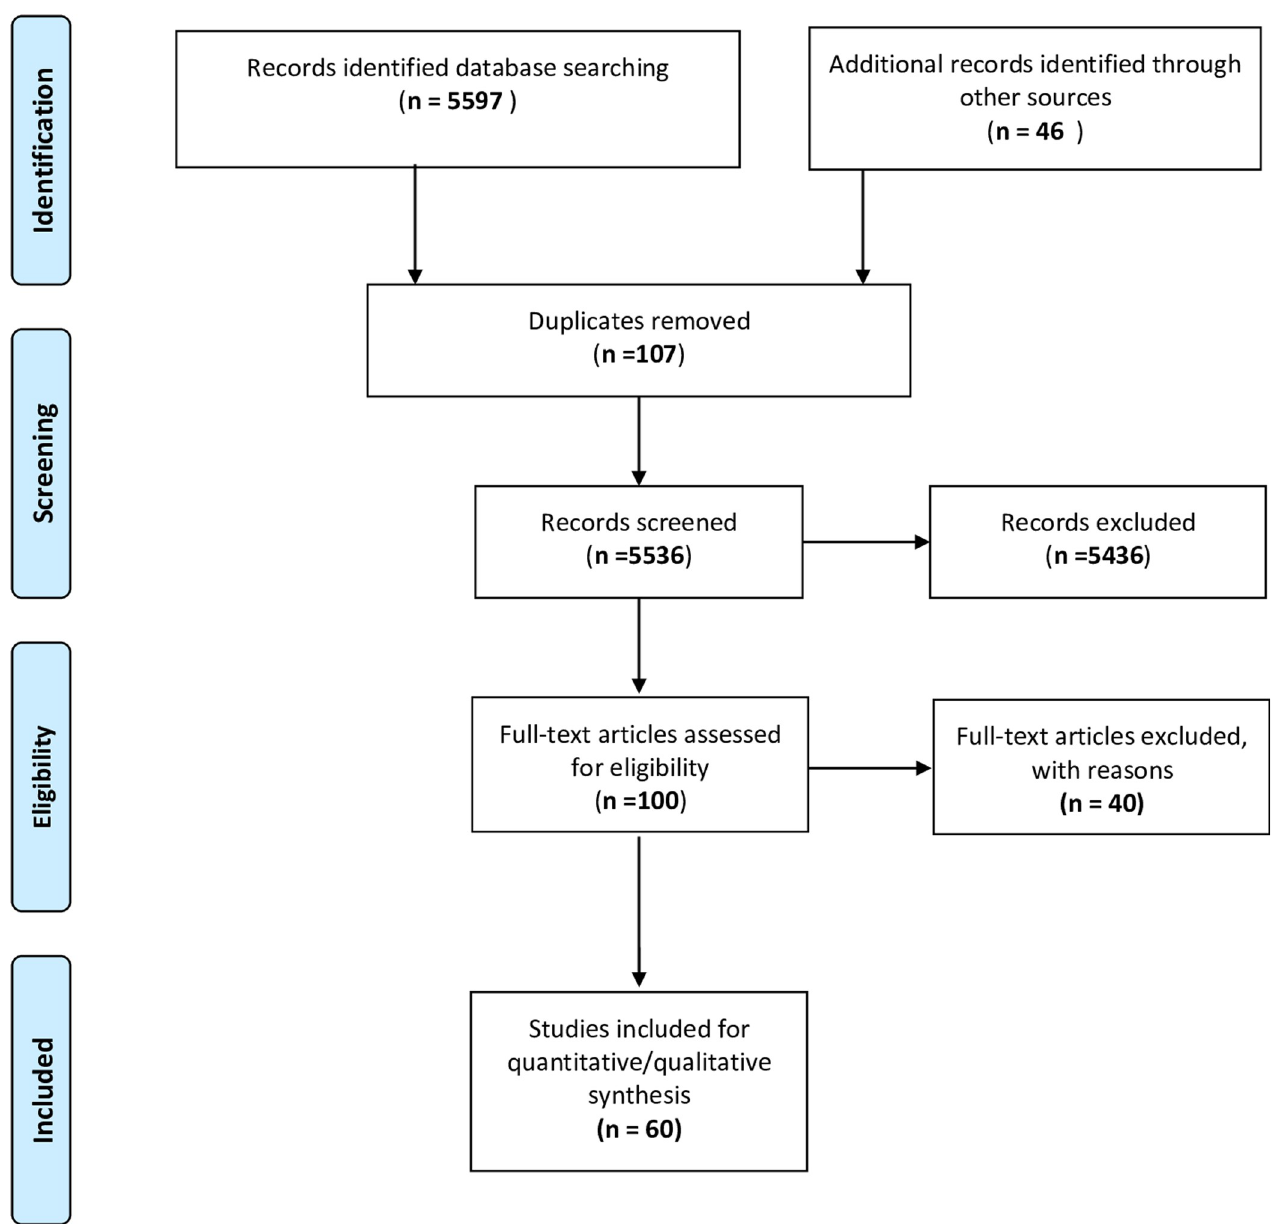
Fig 1. PRISMA flow diagram for the study